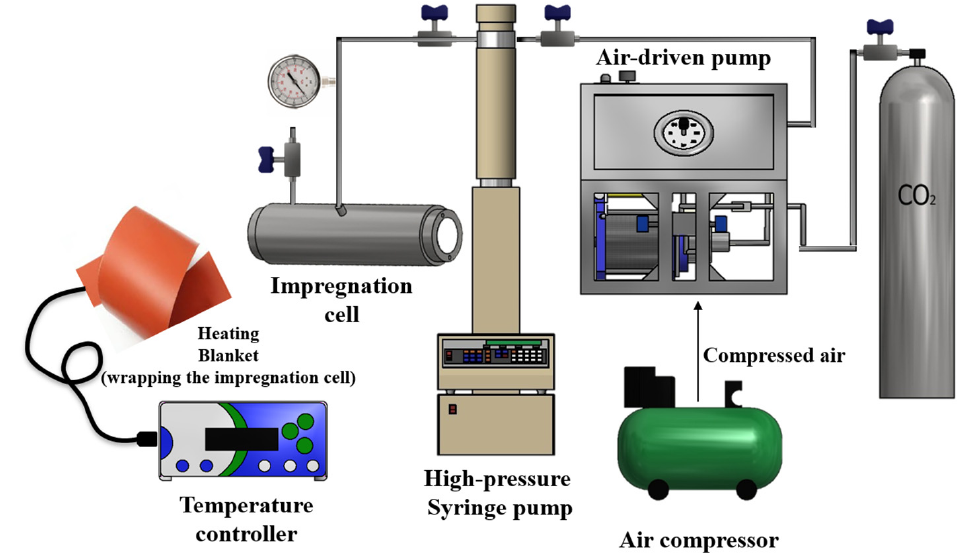
Figure 1. Outline of the experimental set-up for the foaming with scCO 2 and impregnation of the PLA nanocomposite foams [15].